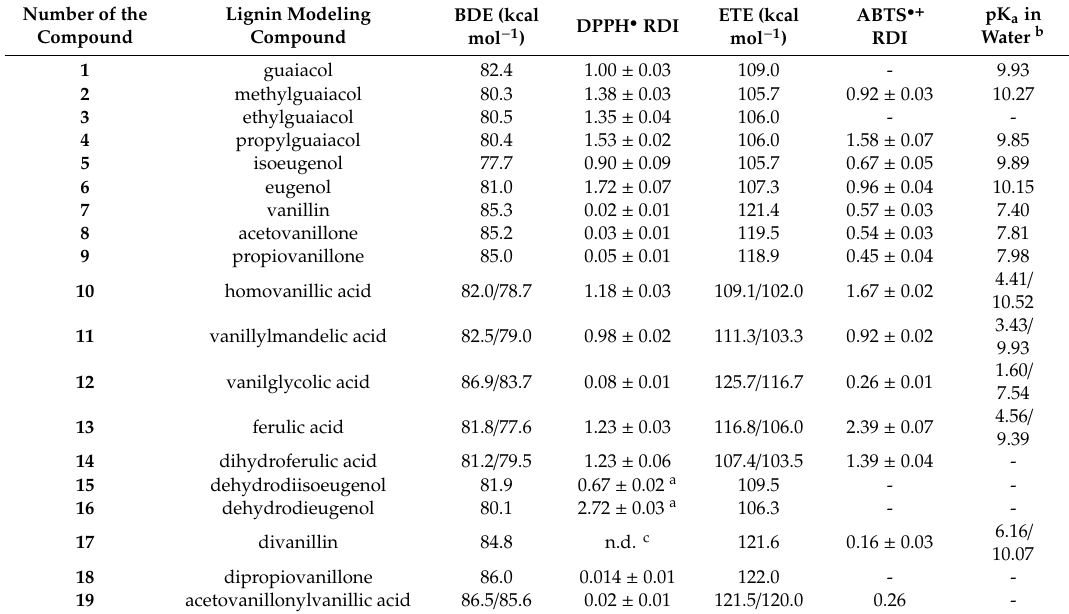
Table 1. Calculated O–H bond dissociation enthalpy (BDE), electron transfer enthalpy (ETE), and radical deactivation indexes (RDI) in DPPH • and ABTS • + assays of the lignin modeling